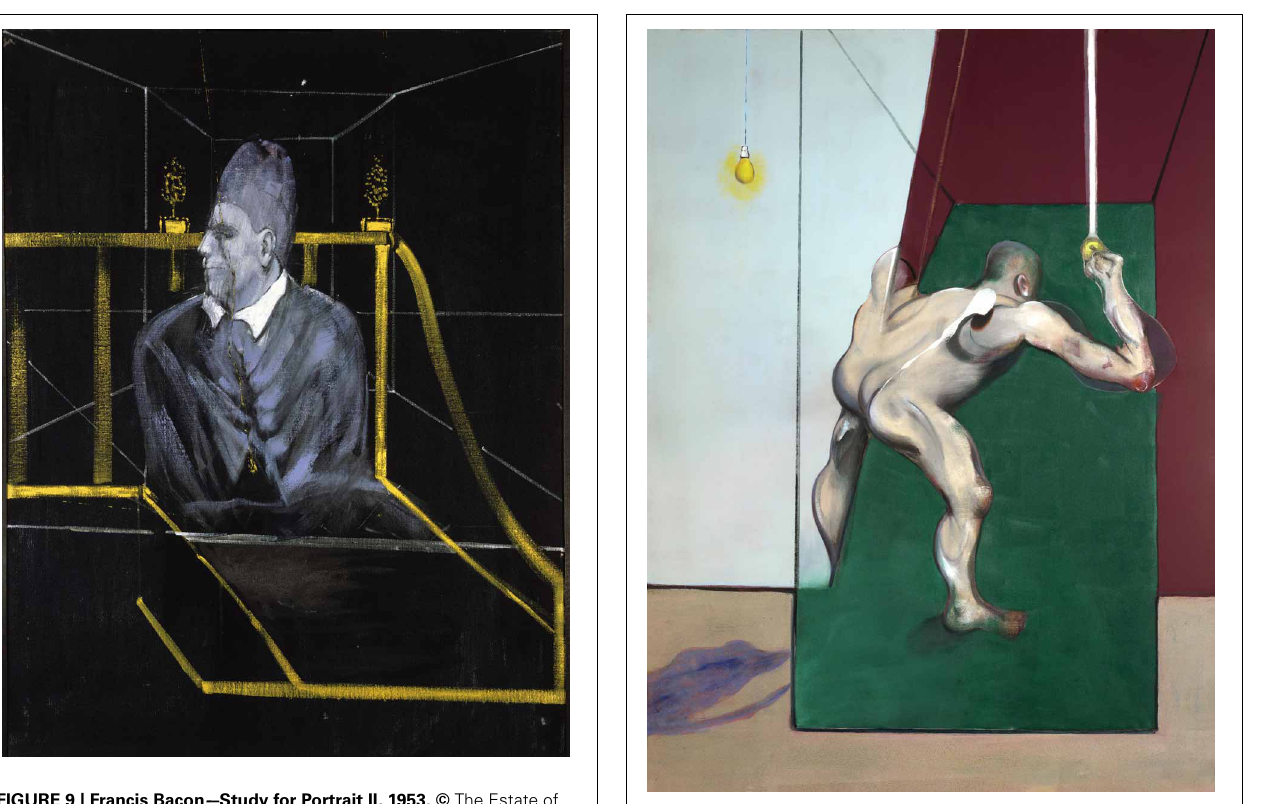
FIGURE 10 | Francis Bacon— Study from the Human Body: Man Turning On the Light, 1973. © The Estate of Francis Bacon. All rights reserved. DACS